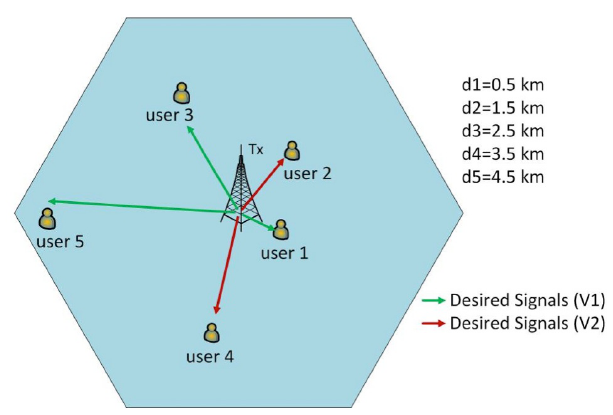
Figure 2. SISO case: 5 users divided into 2 groups. and users 2 , 4 in 𝐺 Users 1 , 3 , 5 in 𝐺 !